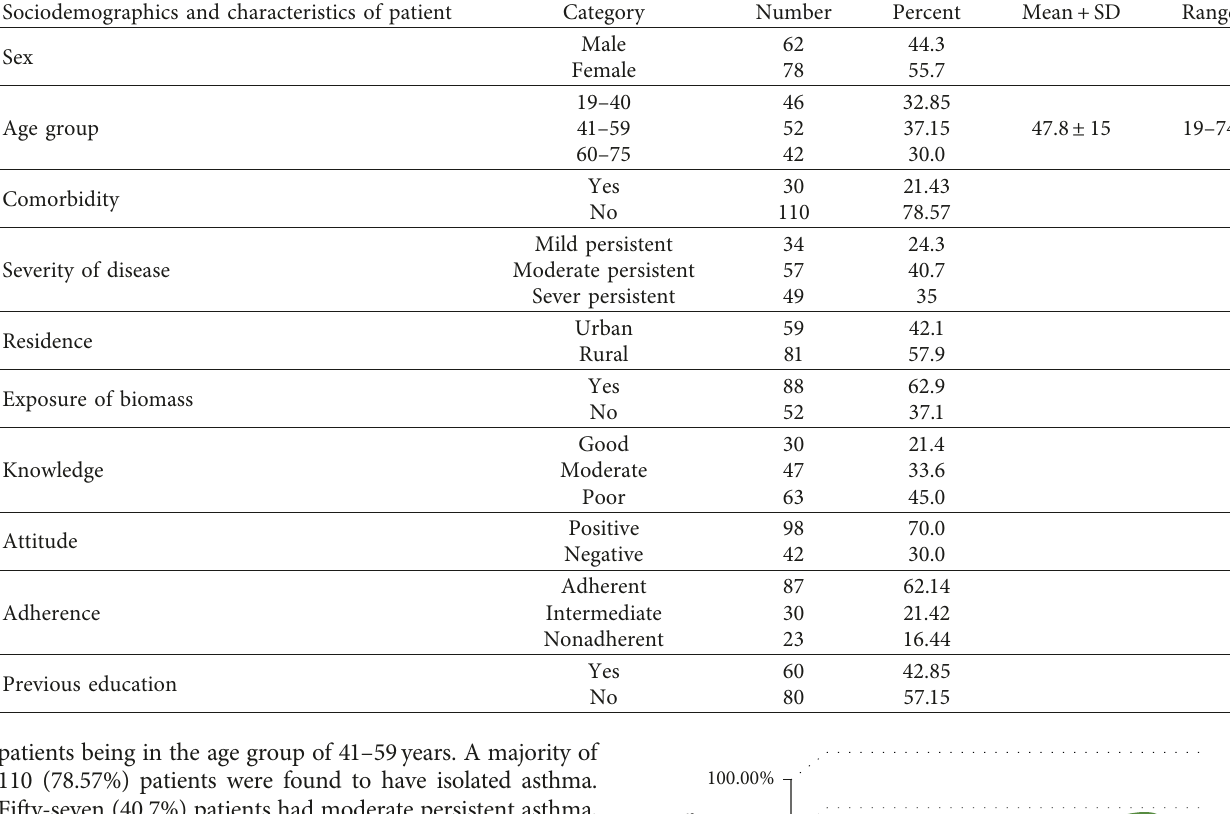
Table 1: Sociodemographic and clinical characteristics of participants, respiratory clinic, JUMC, Ethiopia, 2018. Sociodemographics and characteristics of patient